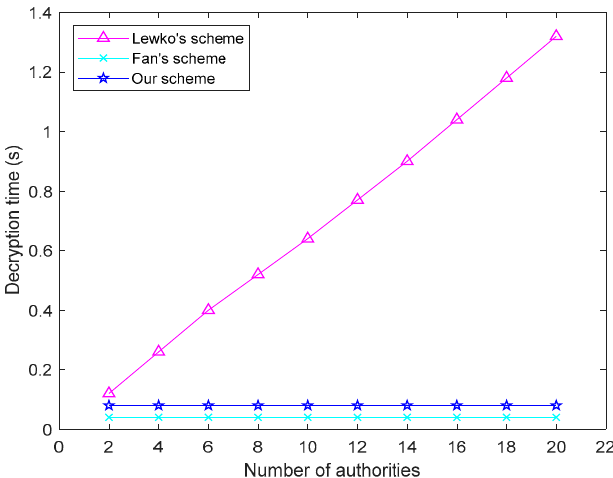
Figure 6. Relation between consumer decryption time and number of authorities.